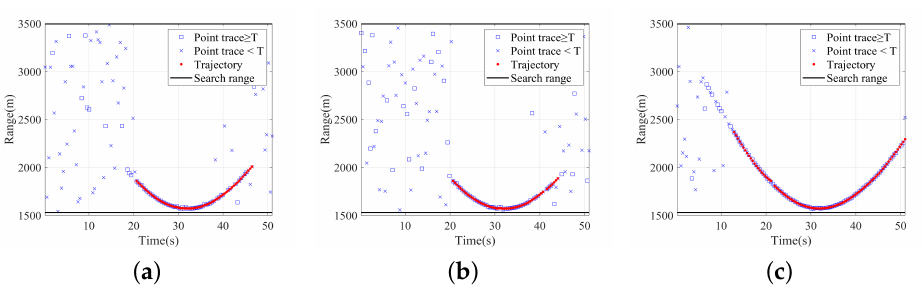
Figure 18. The GRFT, HGRFT and EI-KT results for real data. ( a ) The GRFT result. ( b ) The HGRFT result. ( c ) The EI-KT result.